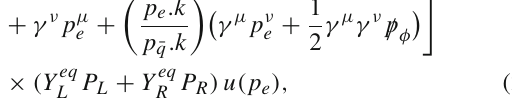
Table1 Specificationofdifferentleptoquarksproducedat e - p